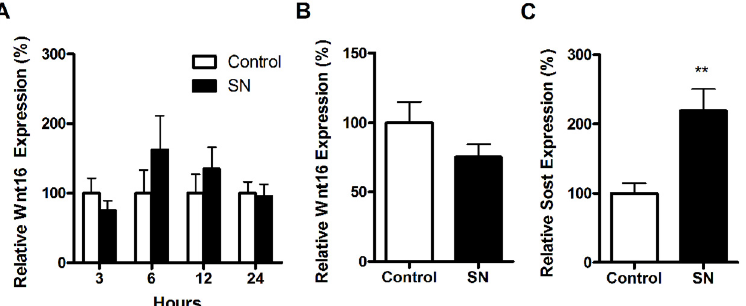
Fig 3. Wnt16 mRNA expression is not affected by unloading in young female mice. Wnt16 expression was unaffected by unloading for (A) 3, 6, 12 and 24 hours, and after (B) two weeks of unloading in young female mice. However, (C) Sost gene expression was significantly increased after two weeks of unloading. Gene expression was determined by quantitative RT-PCR and normalized relative to β 2-microglobulin. Bars represent the mean ± SEM, ** = p < 0.01 vs. sham operated control, N = 6. SN = sciatic neurectomy.